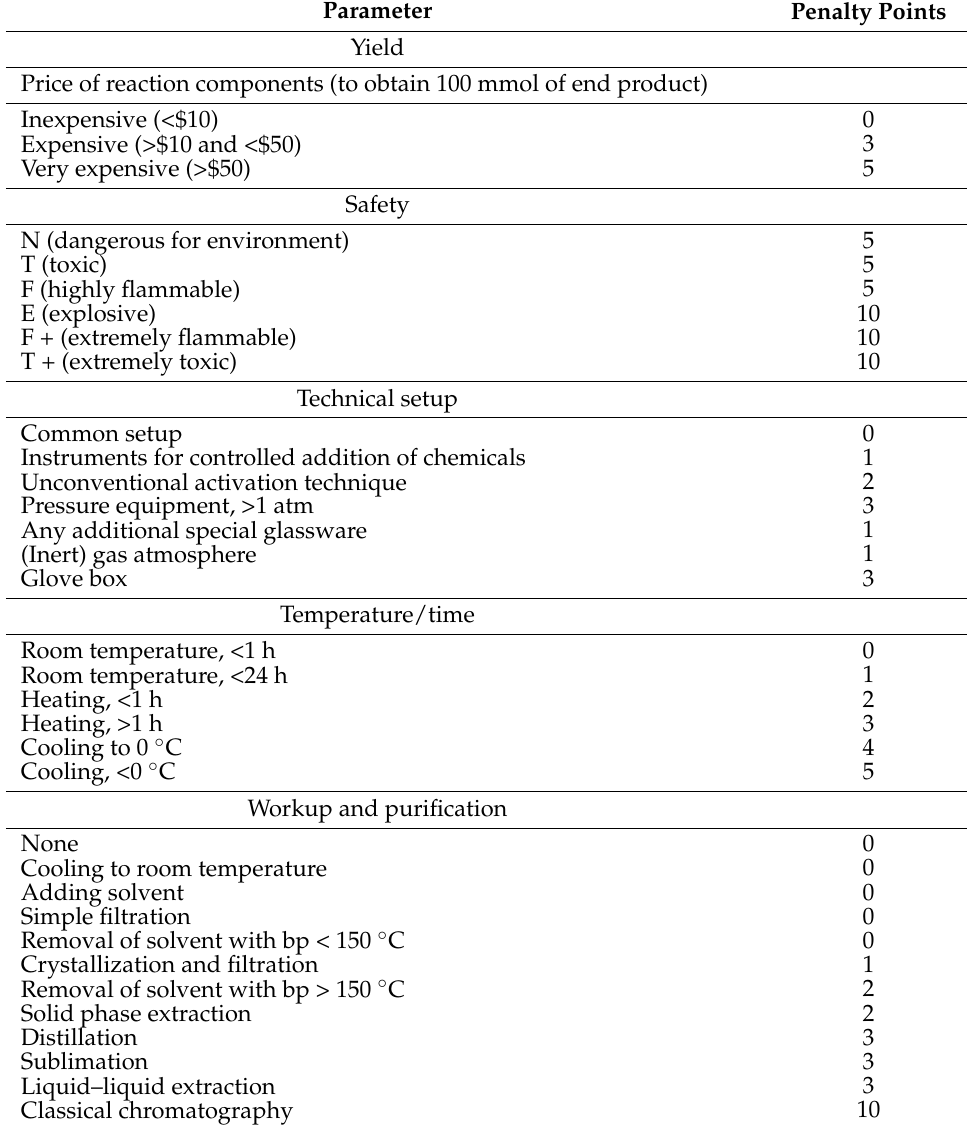
Table 4. The penalty points to calculate the Eco-Scale. Data from Ref. [83]. Parameter Penalty Points Yield Price of reaction components (to obtain 100 mmol of end product) Inexpensive